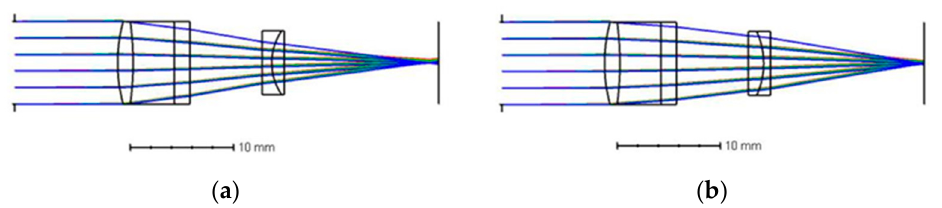
Figure 6. Structural simulation with different refractive indices. ( a ) Refractive index 1.3300 @ voltages of 62 V. ( b ) Refractive index 1.7000 @ voltages of 22 V.